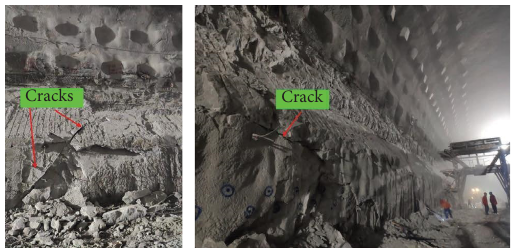
Figure 1: Cracked surrounding rock of the main underground